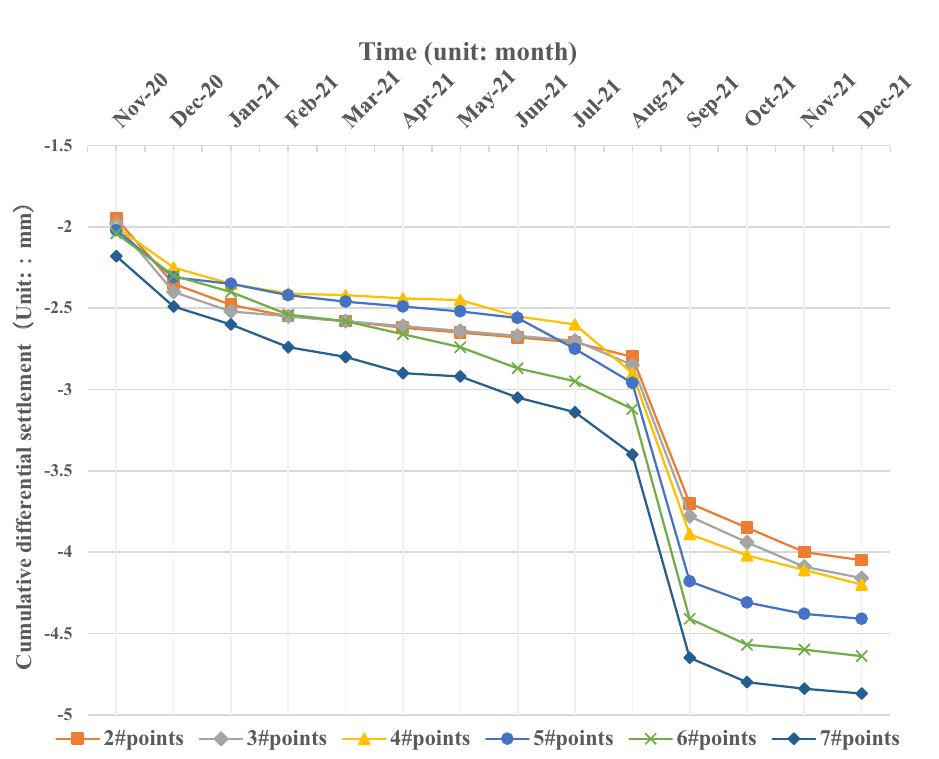
Figure 5. Cumulative differential settlement of monitoring